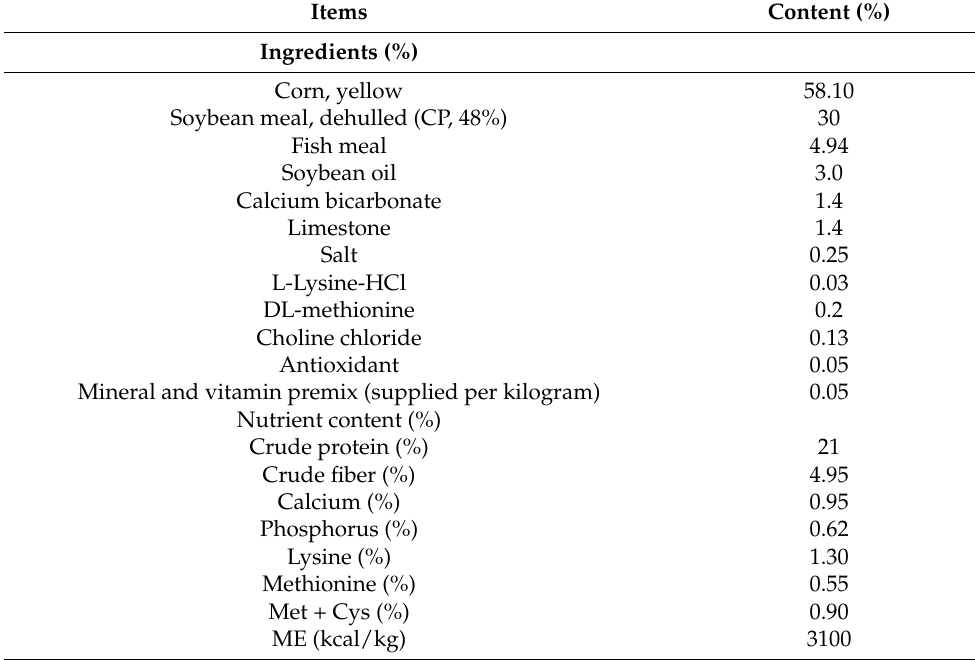
Table 1. Composition of experimental diets. Diet: zinc, 60 mg; iron, 95 mg; copper, 10 mg; iodine, 0.35 mg; selenium, 0.3 mg; manganese, 80 mg; vitamin A, 12,000 IU; vitamin D3, 2750 IU; vitamin E, 30 IU; vitamin K3, 2 mg; vitamin B12, 12 µ g; riboflavin, 6 mg; nicotinic acid, 40 mg; pantothenic acid, 12 mg; pyridoxine, 3 mg; biotin, 0.2